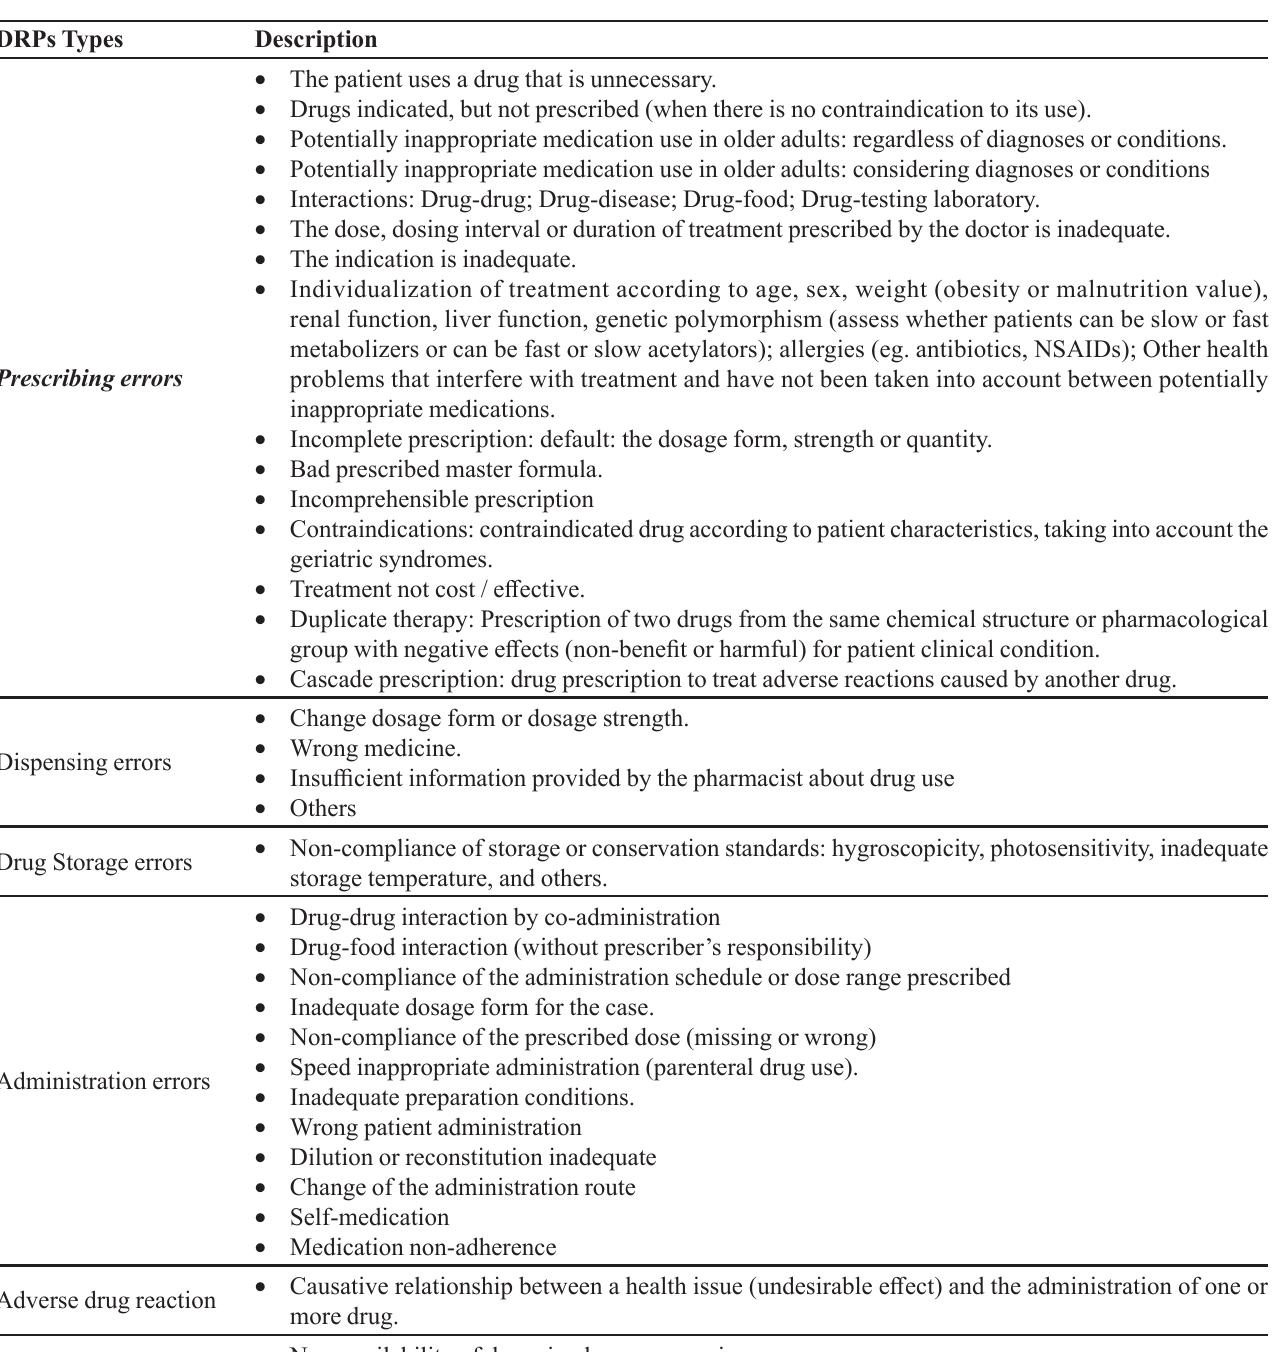
TABLE II - Criteria for the classification of